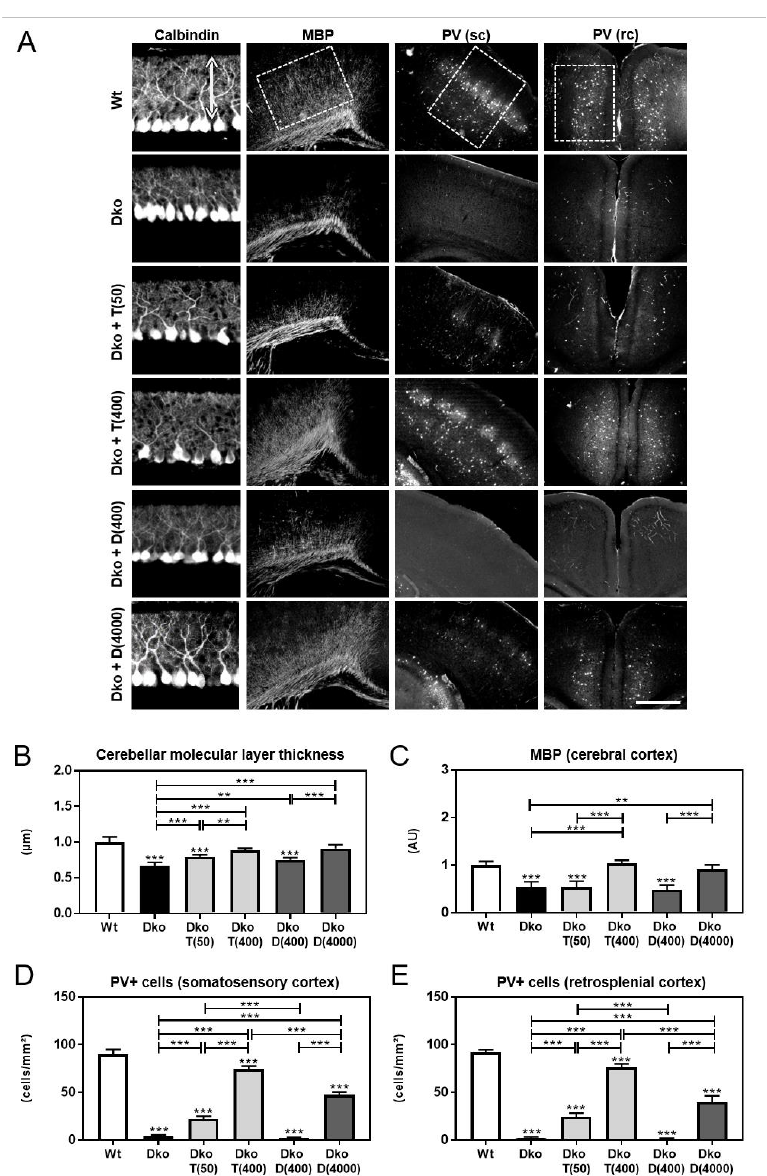
Figure 1. TH-analog treatment initiated after birth improves brain development. Newborn mice received a daily injection of saline (control) or different doses (in ng/g bw) of Triac or Ditpa between postnatal days 1 (P1) and P11, as indicated. ( A ) At P12, cerebellar Purkinje cell development was monitored by calbindin immunostaining and myelination in the cerebral cortex by MBP immunoreactivity, and PV+ interneurons were visualized in the somatosensory cortex (sc) and retrosplenial cortex (rc). ( B ) Dimension of the Purkinje cell dendritic tree (arrow in ( A )) was measured highlighting a reduced thickness in Dko animals that was restored dose-dependently by Triac and Ditpa treatment. ( C ) MBP integrated signal density was determined in the inner layers of the cerebral cortex (box in ( A )) show- ing reduced levels in Dko animals that normalized only upon high-dose Triac or Ditpa administration. PV+ interneurons were enumerated in the sc ( D ) and rc ( E ) (boxes in ( A )). PV+ cells were almost absent in Dko mice and increased dose-dependently following Triac or high-dose Ditpa application. n = 3–5. Scale bars 50 µ m (Calbindin), 500 µ m (MBP), 250 µ m (PV). **, p < 0.01; ***, p < 0.001. Application of TH analogs will affect the activity of the hypothalamus-pituitary- thyroid (HPT) axis by downregulating thyrotropin-releasing hormone (Trh) and thyroid- stimulating hormone subunit beta (Tshb) expression. To directly compare Triac